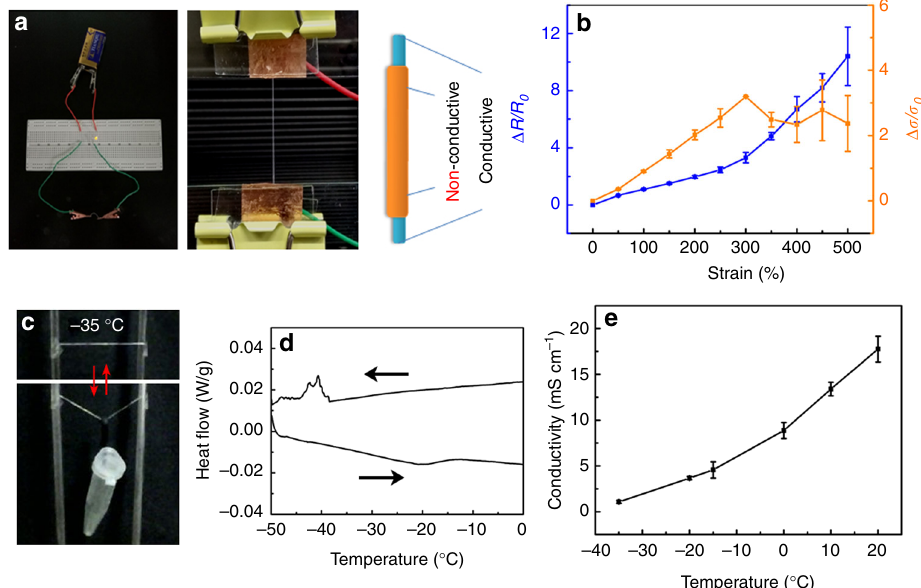
Fig. 4 Electrical conductivity of stretchable and anti-freezing MAPAH fi bers. a MAPAH fi bers can serve as a highly stretchable wire with the PAAS hydrogel as a conductive core and the PMA coating layer as an insulating cover. b Relative resistance variation Δ R / R 0 and relative conductivity variation Δ σ / σ 0 of a MAPAH fi ber upon stretching at 25 °C. c A MAPAH fi ber under repeated weight-bearing test at − 35°C with a plastic vial ~800 times heavier than the fi ber. d DSC of MAPAH fi bers shows a phase transition at around − 40°C. e Conductivity of MAPAH fi bers in the temperature range of − 35 – 25 °C. The error bar for each data point in b and e is standard deviation calculated based on 6 – 8 parallel